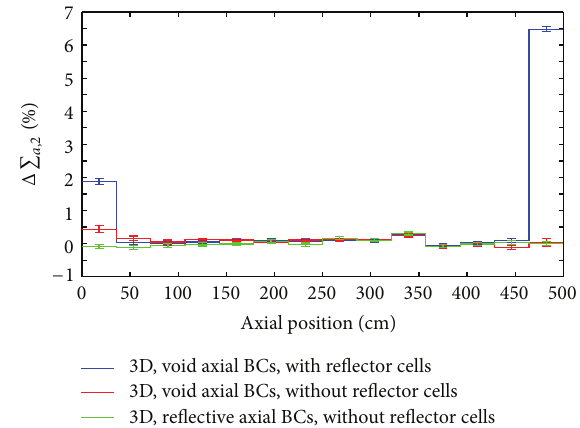
Figure12:Relativedifferencesbetweenabsorptioncrosssectionsfor the thermal